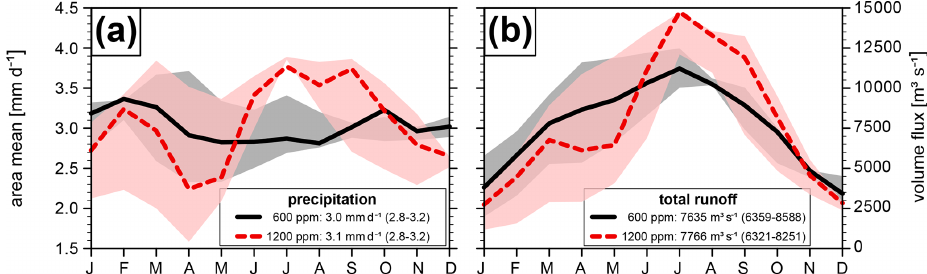
Figure 11. Annual cycle of (a) simulated precipitation and (b) total run-off averaged or integrated over the ∼ 450000km 2 large catchment area shown in Fig. 10. Solid and dashed lines show simulations using a modern orbital configuration at 600 and 1200ppm p CO 2 , respec- tively. Red and grey shadings represent precipitation and run-off ranges related to changes in orbital configuration at 600 and 1200ppm p CO 2 , respectively. Annual means for modern orbit simulations are provided in legends. Results for the cold summer orbit (i.e., maximum precipitation and run-off) and warm summer orbit (i.e., minimum precipitation and run-off) simulations are listed in parentheses.